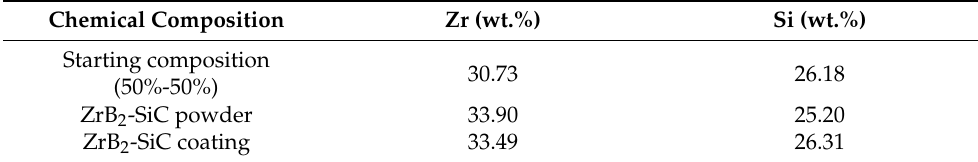
Figure 4. XRD patterns of SiC-ZrB 2 starting powder and coatings. Table 3. Chemical elements analysis determined from energy dispersive X-ray (EDS). Table 3. Chemical elements analysis determined from energy dispersive X-ray